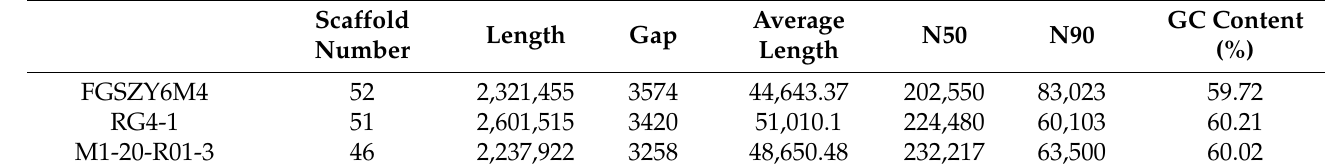
Table 3. Parameters for self-sequenced genomes.